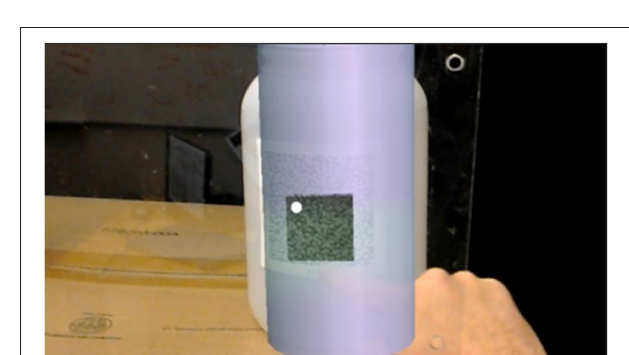
FIGURE 15 | A holographic button is associated with the canister. The button works despite the presence of the polycarbonate sheet.